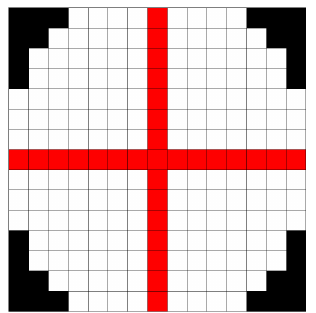
Figure 14. View selection scheme proposed in [68]: The red squares represent the position of the views selected in the mid-density horizontal and vertical